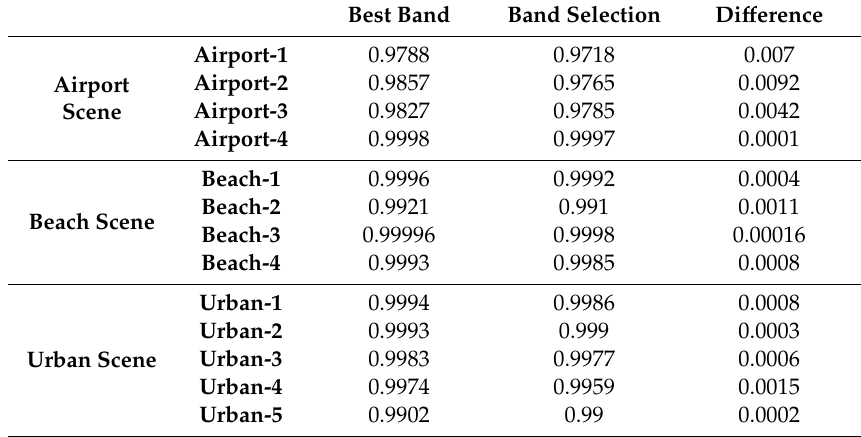
Table 5. Comparison between AUC of the MPAF’s best band and AUC of the MPAF’s selected band on the ABU datasets.